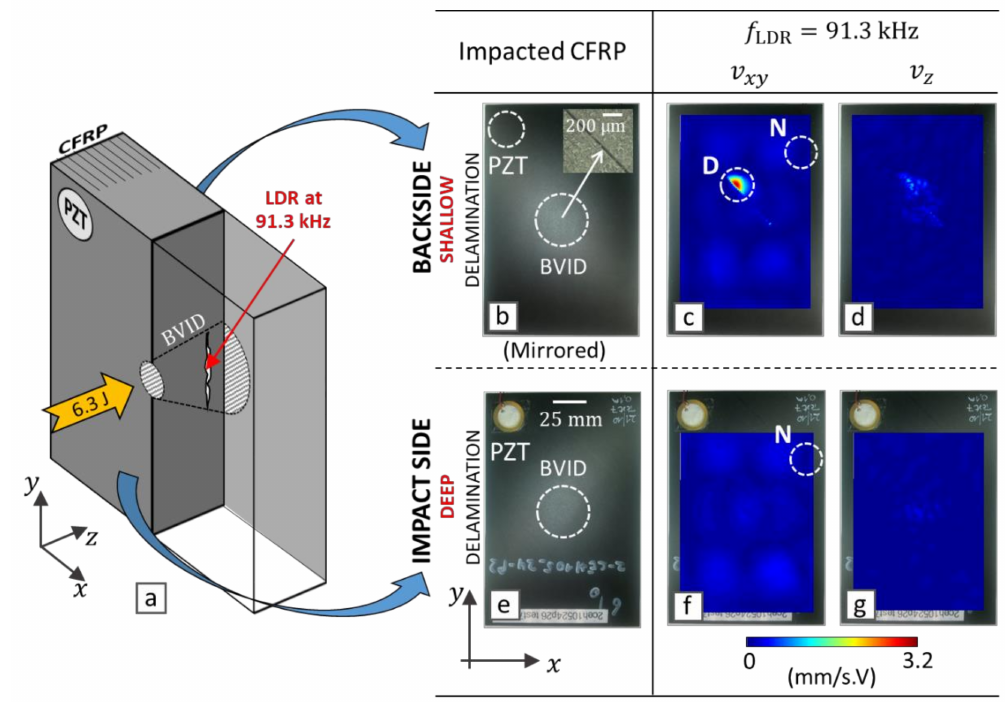
Figure 3. Impacted CFRP coupon of thickness 5.5 mm and corresponding vibrational response (in-plane v xy , and out- of-plane v z ) measured by 3D infrared scanning laser Doppler vibrometer at a selected LDR frequency f LDR = 91.3 kHz, ( a ) schematic presentation of the impacted CFRP, ( b – d ) backside results, ( e – g ) impact side results. D is the resonated fraction of barely visible impact damage (BVID), and N is an in-plane vibrational node of the CFRP